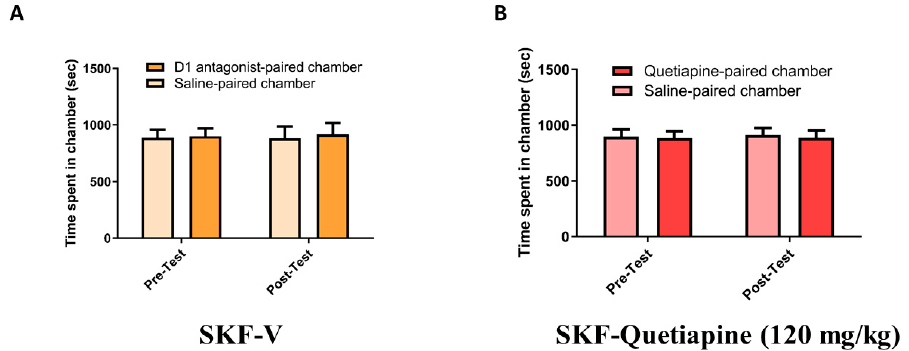
Figure 3. ( A ) Time spent in the D1 antagonist-paired chamber compared with the saline-paired chamber during pretest and post-test in the SKF-V group (treated with SKF followed by vehicle). ( B ) Time spent in the quetiapine-paired chamber compared with the saline-paired chamber during pretest and post-test in the SKF-Quet group (treated with SKF followed by quetiapine). Values are shown as means ± standard errors of the